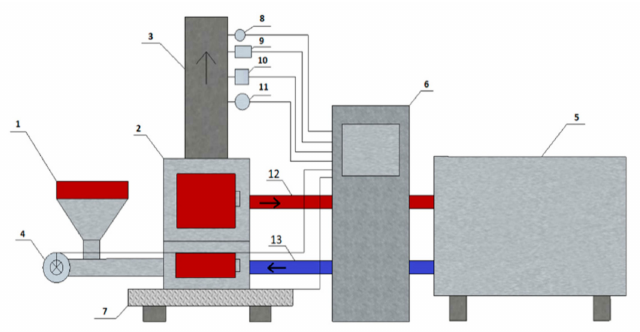
Figure 4. Scheme of experimental setup: 1—fuel tank, 2—pellet boiler, 3—chimney, 4—blower, 5— heat exchanger station, 6—flue gas analyzer and data logger, 7—scale, 8—draft pressure sensor, 9— and 10—mission probes, 11—thermocouple, 12—cold water, 13—hot water.